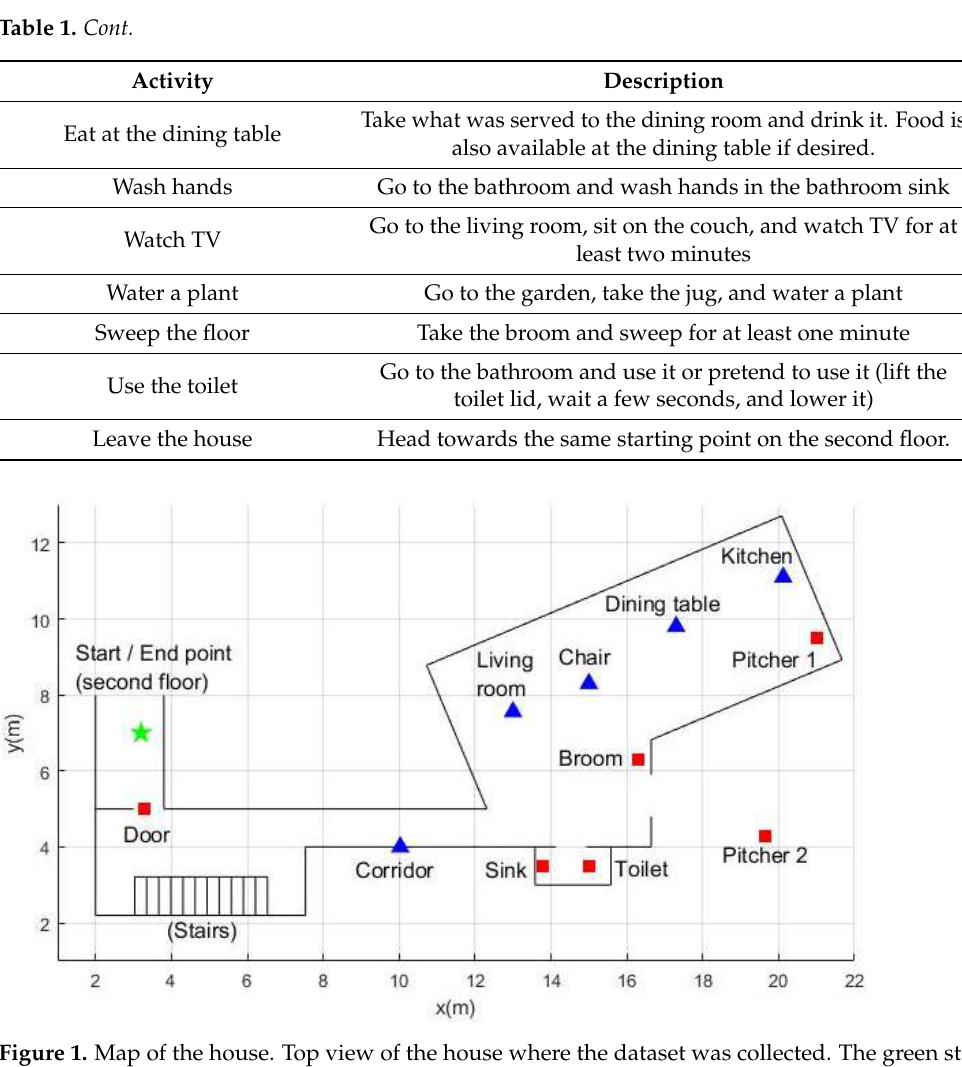
Figure 1. Map of the house. Top view of the house where the dataset was collected. The green star indicates the start and end coordinates of data collection. The blue triangles represent stationary beacons, and the red squares are active or mobile beacons. Table 1. Activities carried out by participants during data collection.